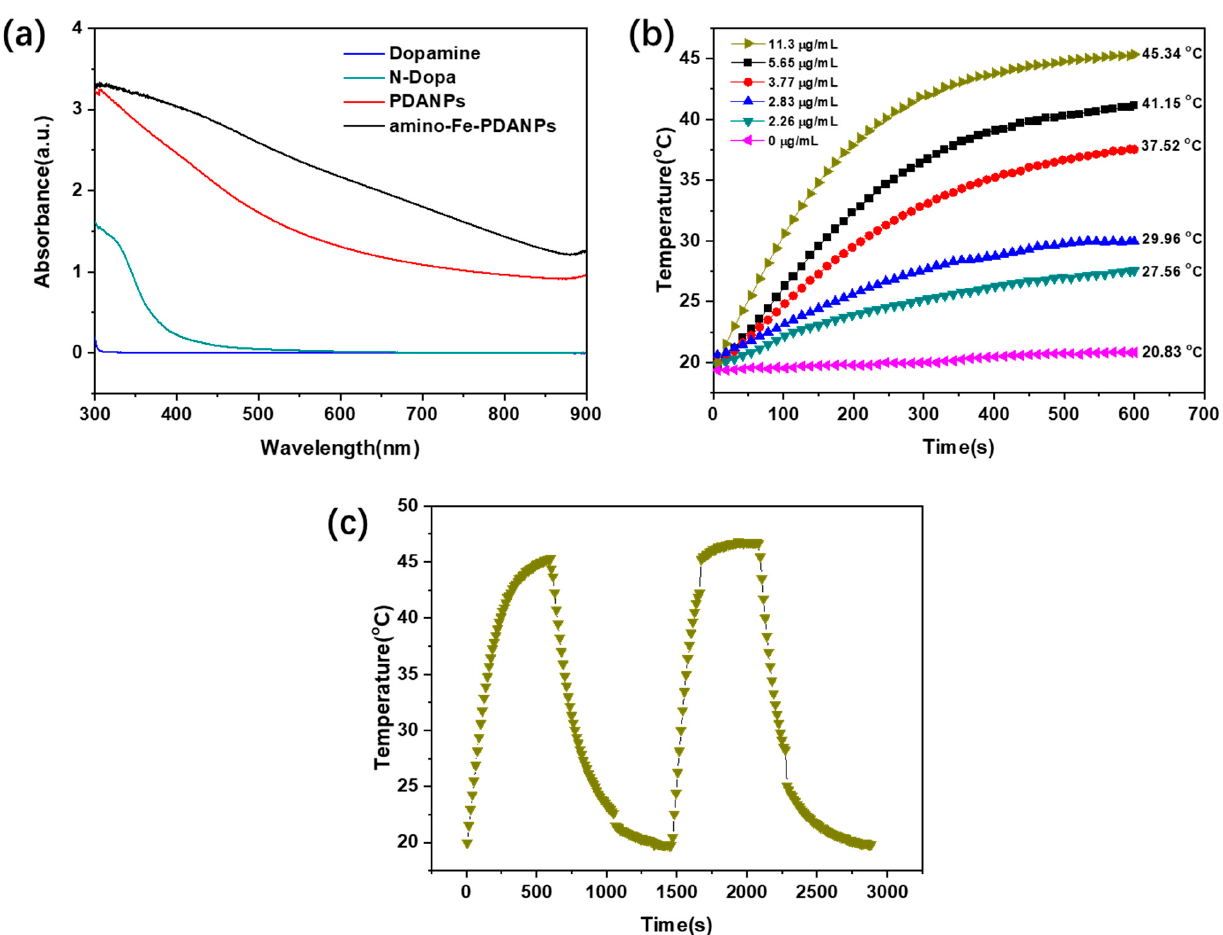
Figure 6. ( a ) UV–vis absorption spectra of Dopamine, N-Dopa, PDANP S and amino-Fe-PDANP S , the concentrations are 1 mg mL − 1 ; ( b ) Temperature elevation of water and amino-Fe-PDANP S aqueous solutions with different concentrations over the irradiation time; ( c ) The repeated photothermal response of the amino-Fe-PDANP S aqueous solution.